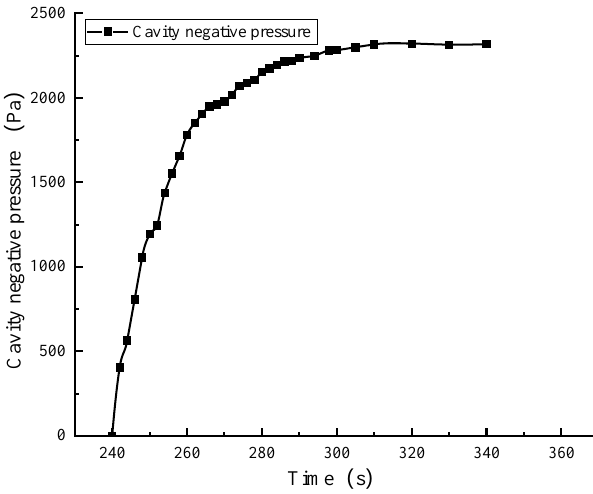
Figure 9. Time-lapse curve of the drainage and cavity pressure .